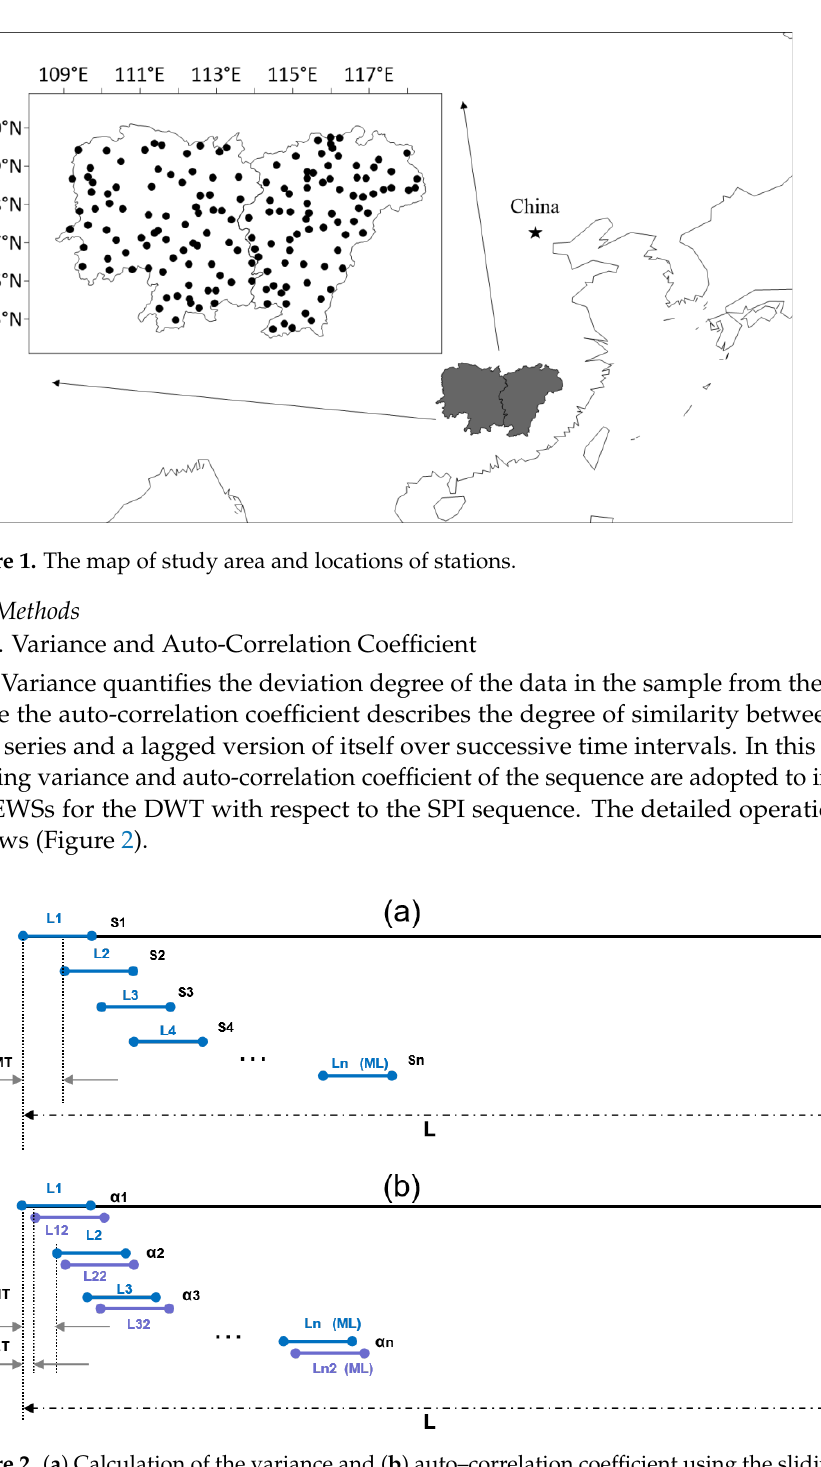
Figure 2. ( a ) Calculation of the variance and ( b ) auto − correlation coefficient using the sliding win- dow method.